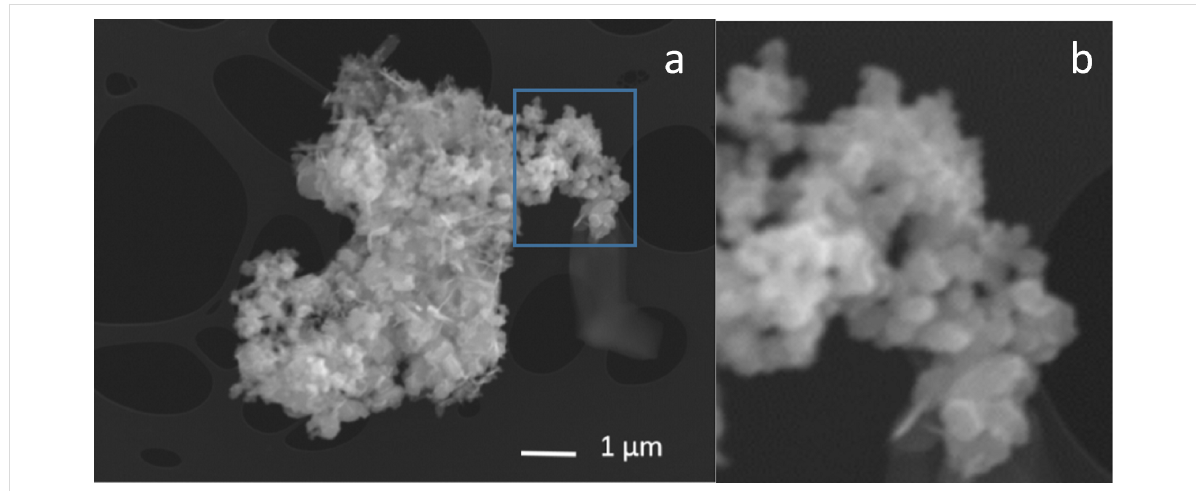
Figure 6: SEM image of an aggregate/agglomerate of sample C (SiO 2 400 mJ/pulse); b) details from panel a.